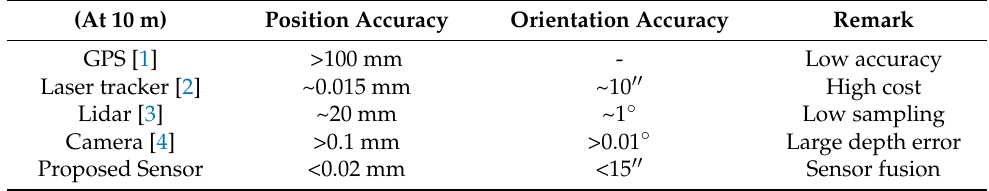
Table 1. Comparison of multi-DOF sensors for long-distance measurement range. (At 10